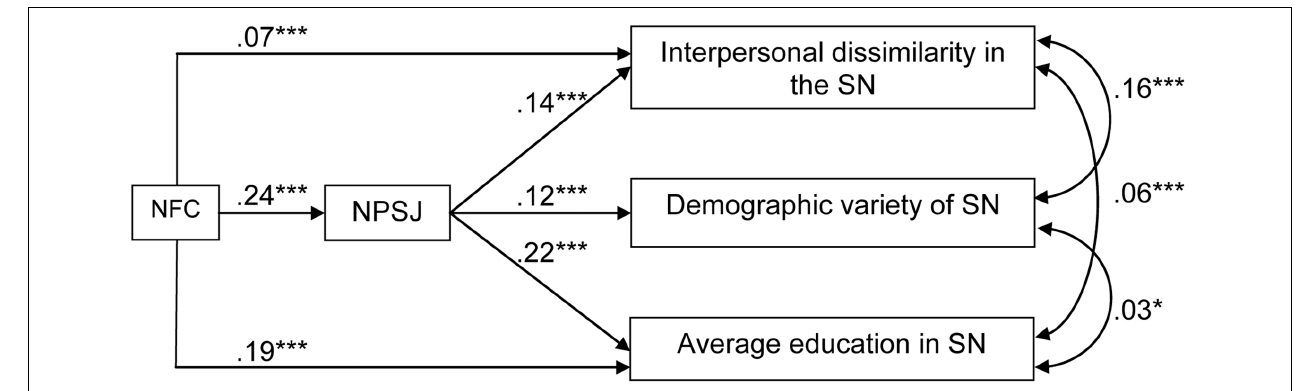
FIGURE 1 | The results of the overall path model. Values represent standardized path coefficients ( ∗∗∗ p < 0.0001, ∗∗ p < 0.01, and ∗ p < 0.05); NFC, need for cognition; NPSJ, non-prejudicial social judgments. Fit indices: chi-square = 5.97, df = 1, p = 0.01, CFI = 0.99, TLI = 0.92, NFI = 0.99, RMSEA = 0.024.